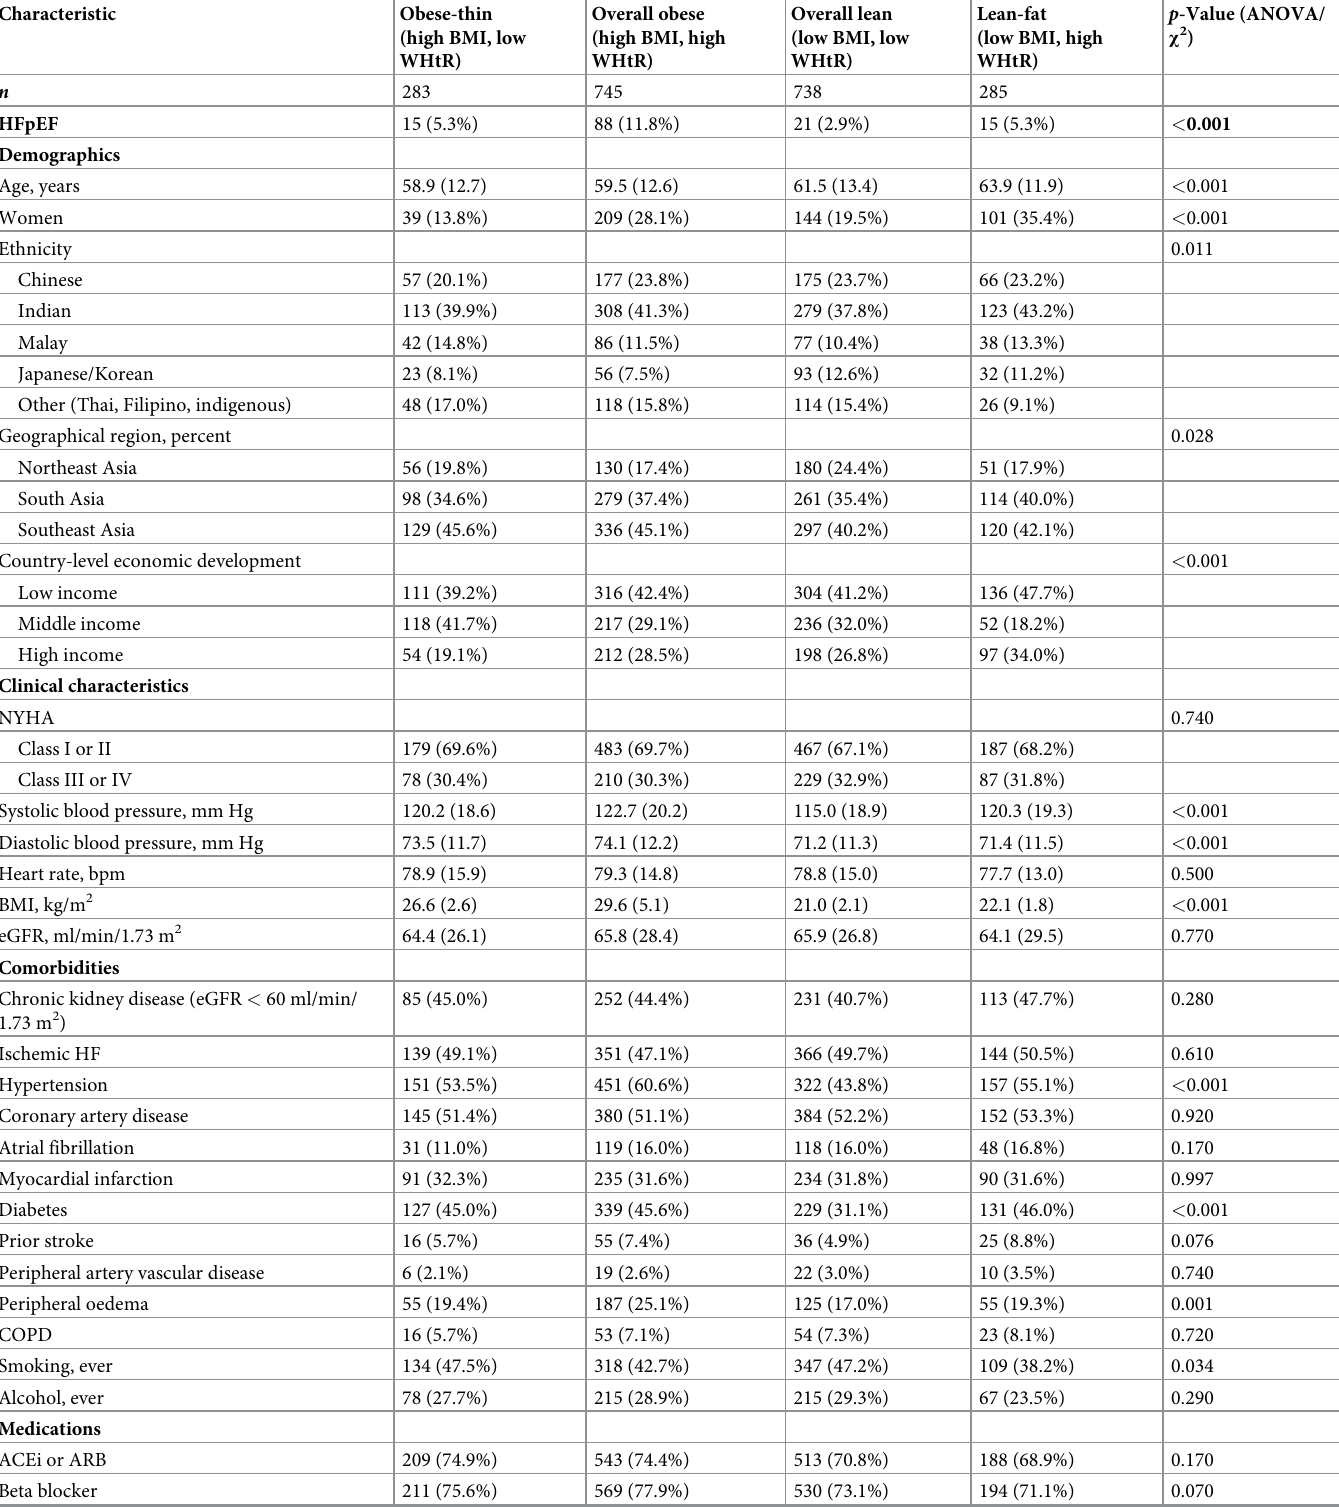
Table 1. Baseline characteristics and 1-year outcomes by BMI and WHtR